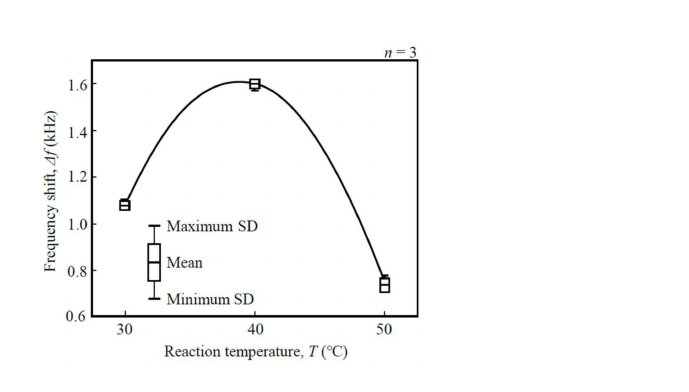
Figure 8. Influence of the temperature of reaction chamber, T , on the frequency shift, ∆ f (1.402 MHz measured frequency).